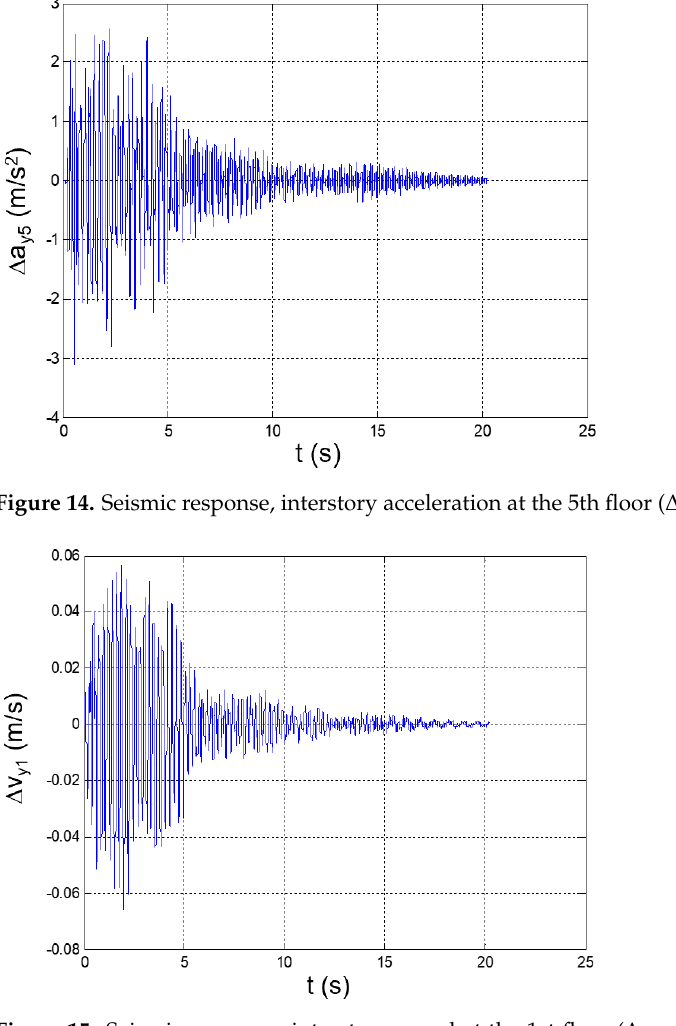
respect to the ground).